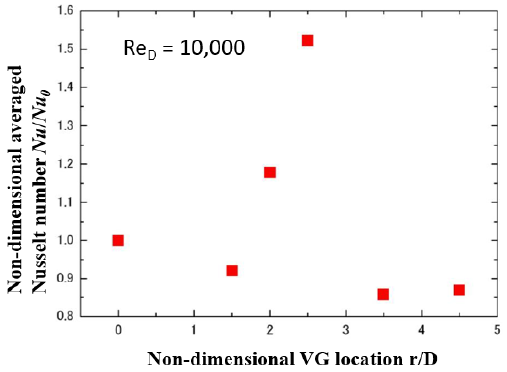
Figure 13. E ff ect of VG location on the local Nu distribution along boundary line in Figure 9 (fixed VG height: e / δ = 1.0).